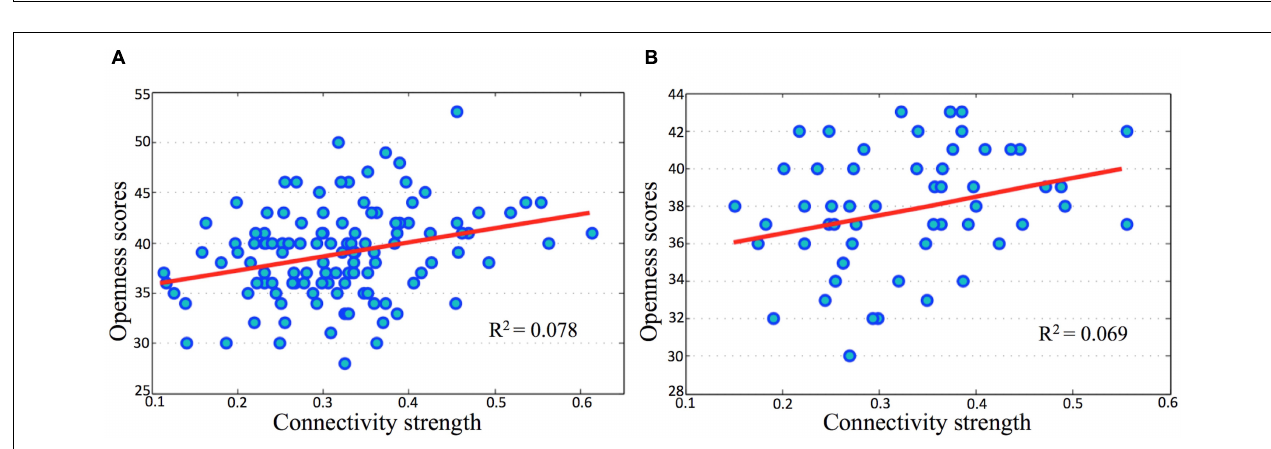
FIGURE 3 | Voxel-wise functional connectivity analyses validate gRAICAR findings. (A) Three regions of interest including the PCU, the l-IPL and the r-IPL. (B) Map of the parietal memory network showing inter-regional connections exhibiting significant (red line) and non-significant (blue lines) differences in connectivity strength (Fisher’s Z ) between LOS and HOS groups. (C,D) Bar graphs showing statistical results in comparing functional connectivity strength between LOS and HOS groups. (C) presents the results from the discovery sample and (D) from validation sample. Labels along the horizontal axis correspond to the connections marked on (B) . In both the discovery data and the validation samples, the connectivity between bilateral IPL shows significant difference between LOS and HOS groups.